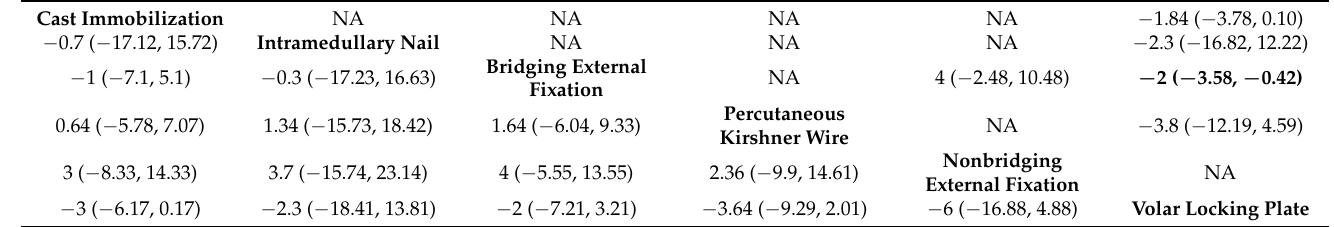
Table 1. Absolute and relative mean difference estimates (95% CI) on DASH questionnaire. Upper right triangle gives the mean difference from pairwise comparisons (column intervention relative to row) and lower left triangle gives the mean difference from the network meta-analysis (row intervention relative to column).